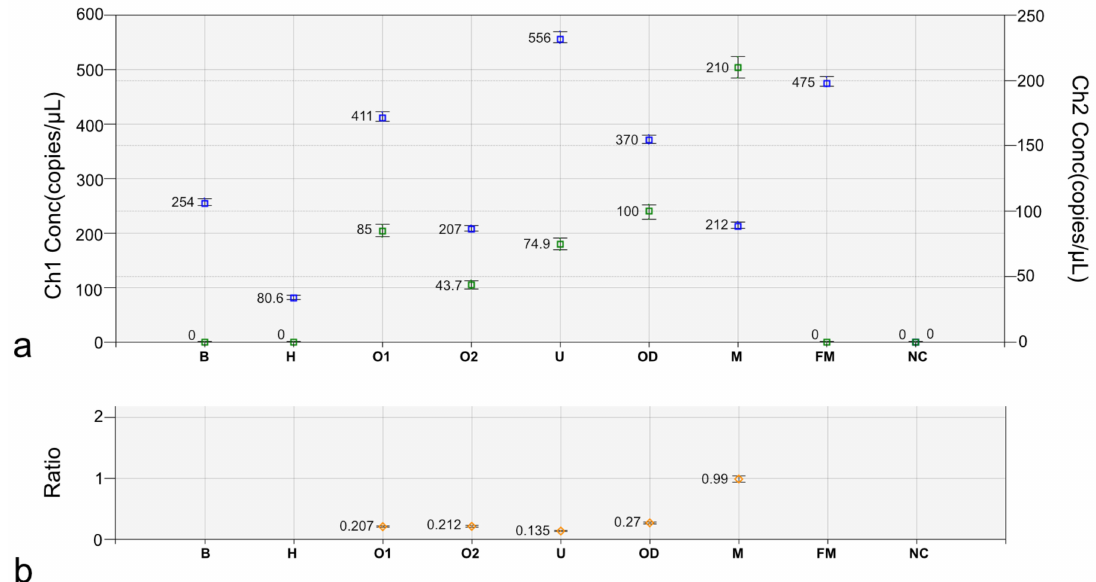
Figure 6. Estimation of the Y/X ratio by ddPCR based on the proportion of AMELY (Ch2) and AMELX (Ch1) amplicons in the DSD heifer #7514. ( a ) Amplification signals from chromosome X (blue color) and Y (green color). ( b ) Y/X ratio is presented. B: blood; H: hair follicles; O1: ovary 1; O2: ovary 2; U: uterus; OD: oviduct; M: control male; FM: control female; NC: negative control (no